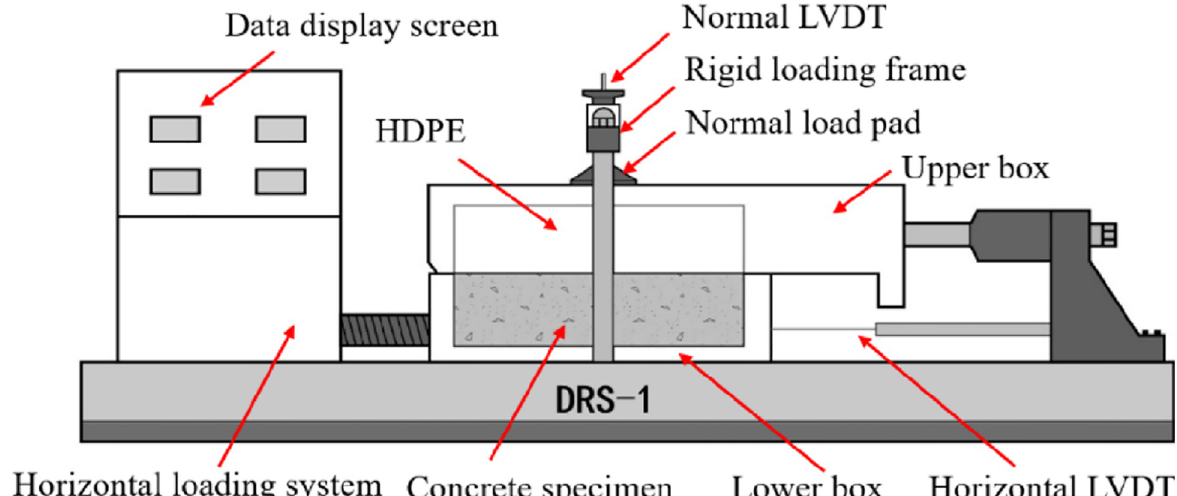
Fig 7. Schematic diagram of direct shear machine DRS-1.